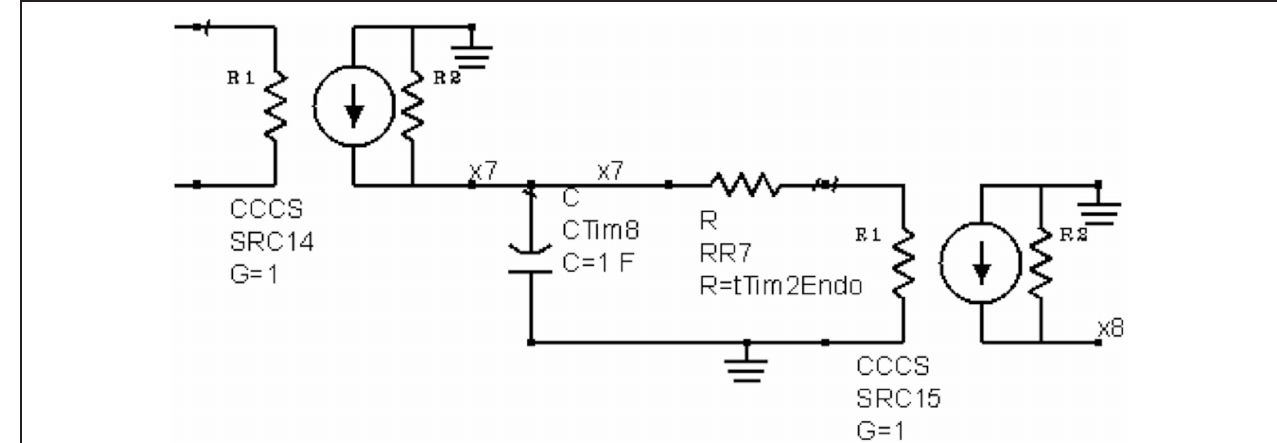
FIGURE 2 | An example circuit generated by ODE-to-circuit conversion. The component on the left is a current-control current source (CCCS), an ideal element for current scaling. The scaling factor G = 1 for the element mirrors the current, representing iron atoms in a TIM-2/ferritin complex. The current inputs into a capacitor are to model